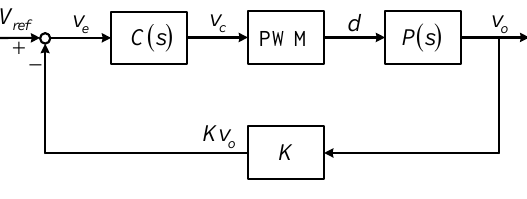
Figure 8. Control system block diagram.